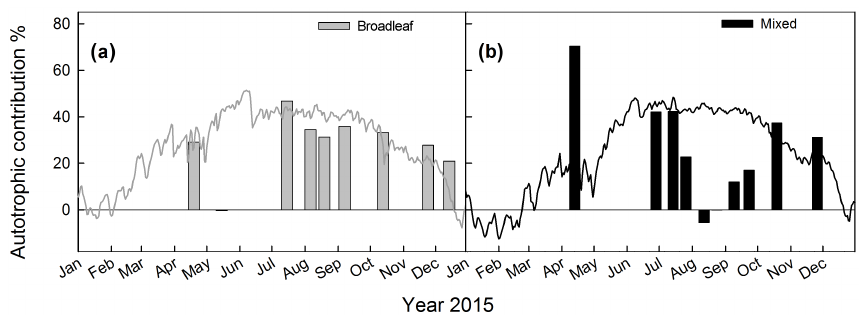
Figure 3. Contribution of autotrophic soil respiration ( R a ) to total soil CO 2 efflux ( R s ) at a (a) broadleaf and (b) mixed forest in Bhutan Himalayas. Autotrophic contribution was derived from the differences between R s measured at control and trenched plots (bars) and from the differences between modelled R s and heterotrophic soil respiration rates (lines),